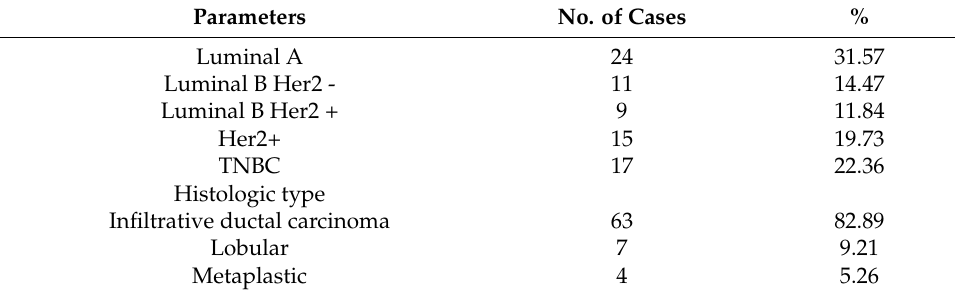
Table 1. Patient classification based on the molecular subtype, histological type, and pres- ence/absence of